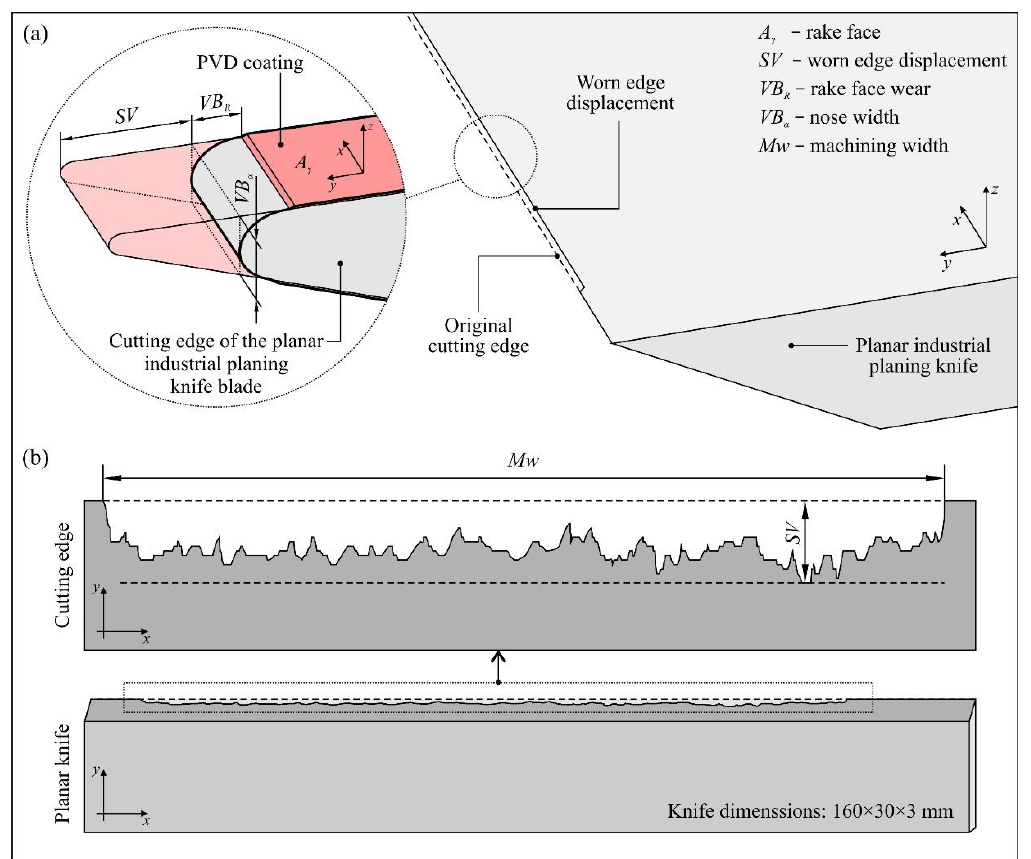
Figure 1. Graphical representation of ( a ) the cutting edge of the industrial planer knife blade with associated nomenclature; ( b ) basic elements of the machining width ( Mw ) and worn edge displacement ( SV ) of the cutting edge.